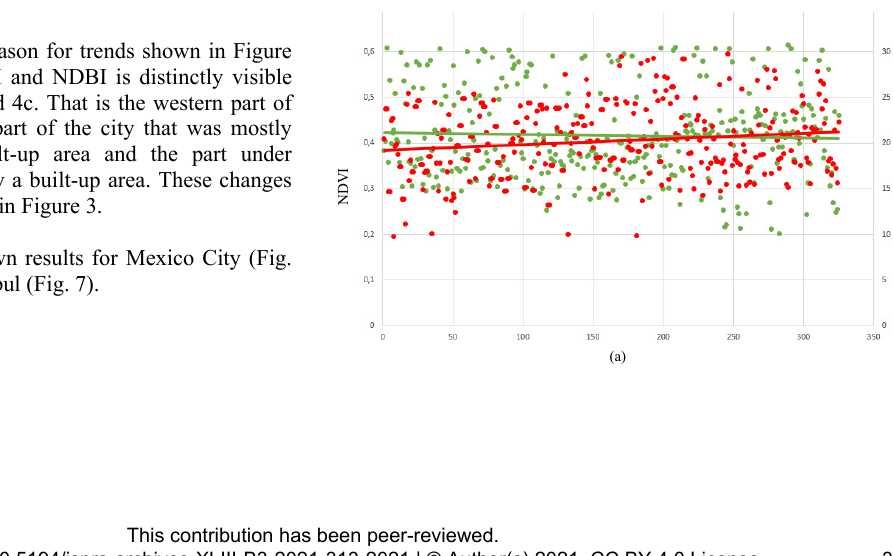
Figure 4. Land cover classification for Tokyo for years (a) 1990, (b) 1999 and (c) 2020. The built-up area will be shown red, vegetation green, and water blue, respectively.